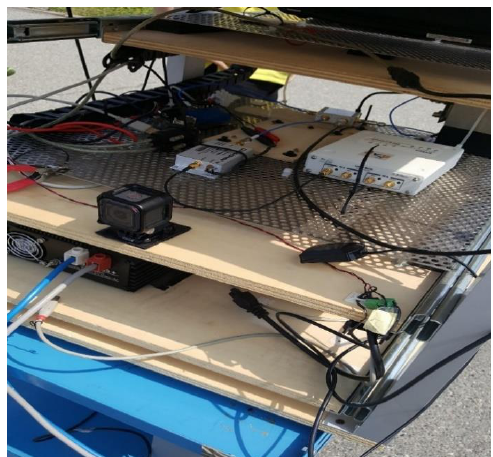
Figure 14. The complex integration setup.